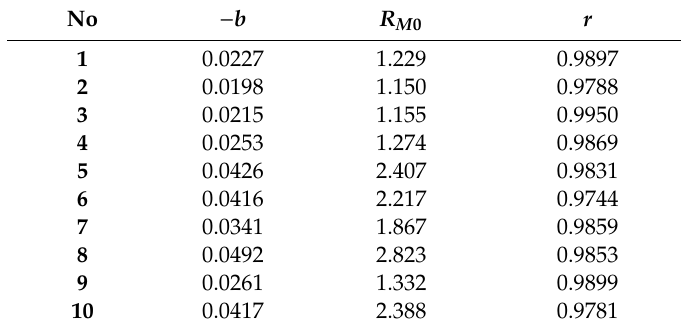
Table 2. The R M 0 , b (slope), and r values of the equation R M = R M 0 + b C for compounds 1–10 . No −